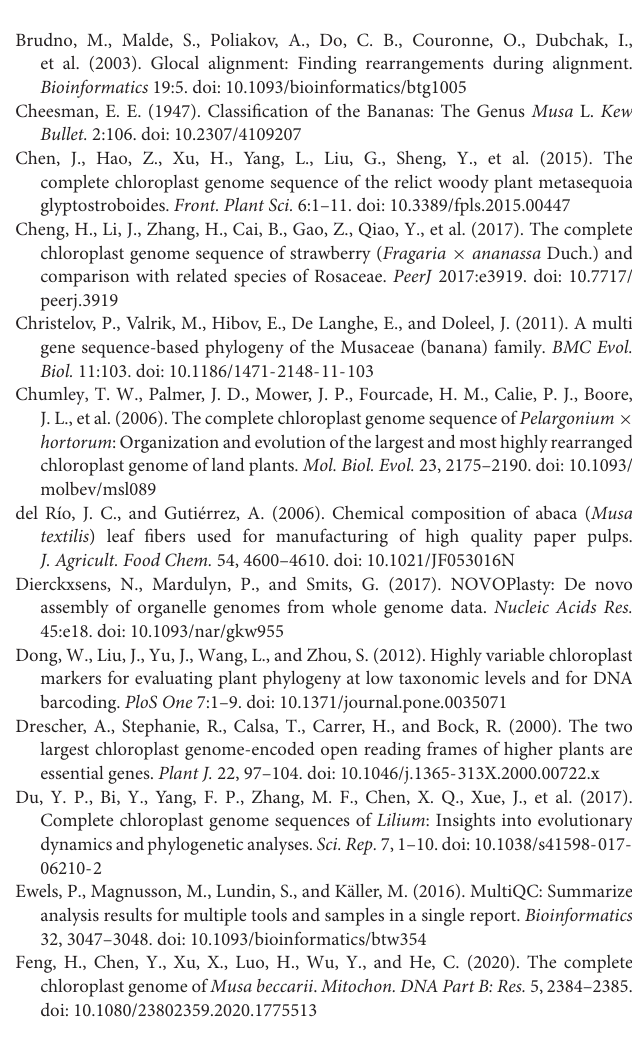
Supplementary Table 1 | Intron details. Supplementary Table 2 | Codon usage details all nine Musa species. Supplementary Table 3 | K a / K s raw data all nine Musa species. Supplementary Table 4 | RNA editing sites raw data of all nine Musa species. Supplementary Table 5 | Detail of SSR and long repeats. Supplementary Table 6 | SNP and InDels statistics. Supplementary Table 7 | Raw data of Pi values. Supplementary Table 8 | Information of species in phylogenetic